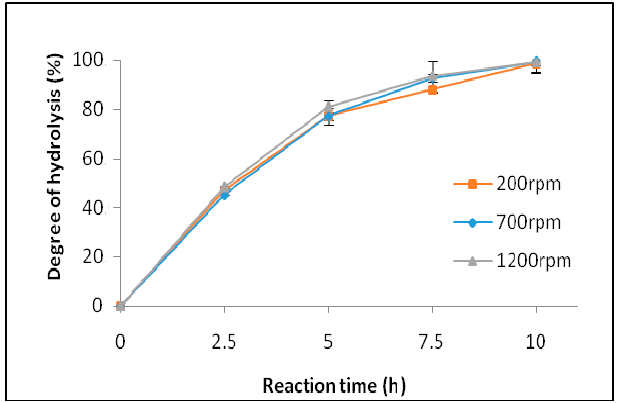
Figure 12. Effect of the stirring speed to the hydrolysis on Schizochytrium sp. oil. (Reaction temperature = 95 °C, Water to oil ratio = 3:1 (w:w), 1% Sodiumdodecyl-sulfate based on oil weight, 1.4 mol/L sulphuric acid).